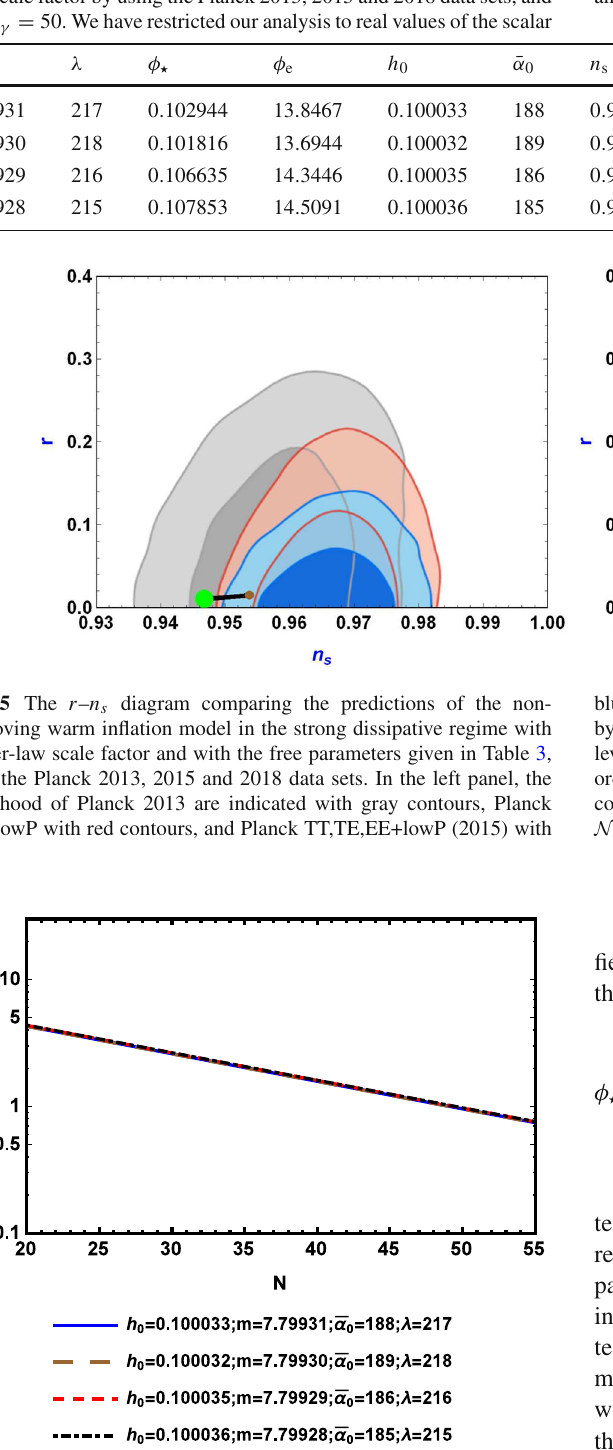
field at the horizon exit. To obtain the presented results we have fixed the power spectrum to its horizon exit value, i.e., P s = 2 . 17 × 10 − 9 , and we have used a ζ = 0 . 127, and b ζ = 4 . 330, respectively